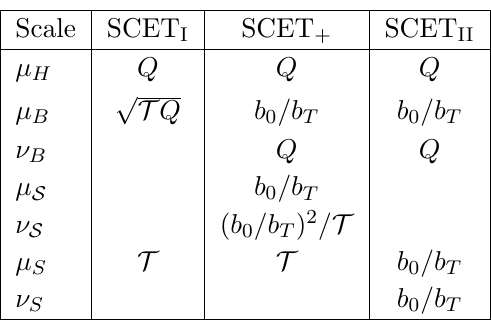
Table 1 . Summary of canonical scales in SCET I , SCET + , and SCET II [see eq. (2.10),